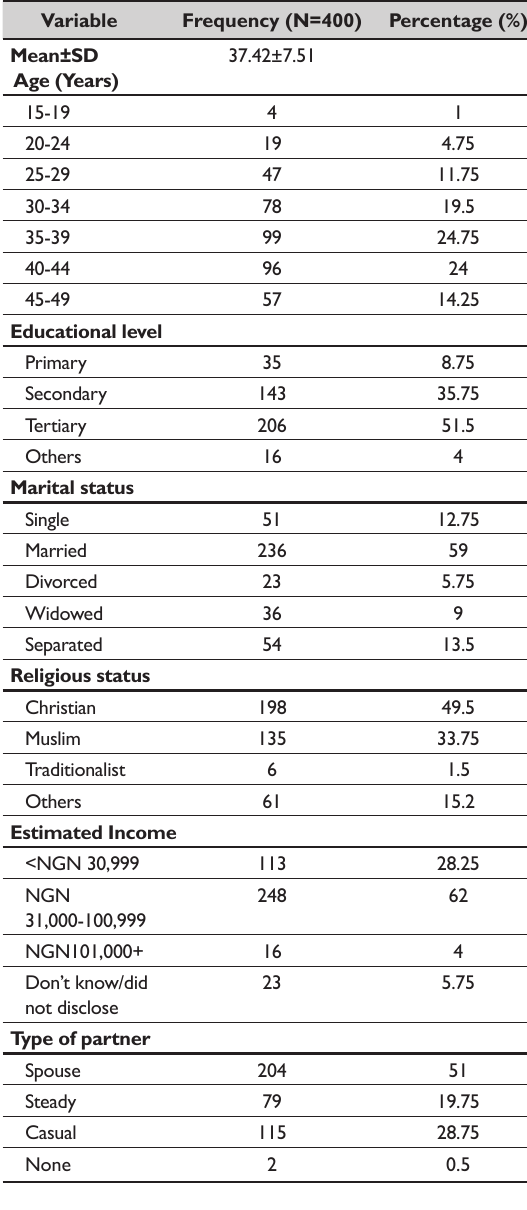
Table 1: Socio‑demographic characteristics